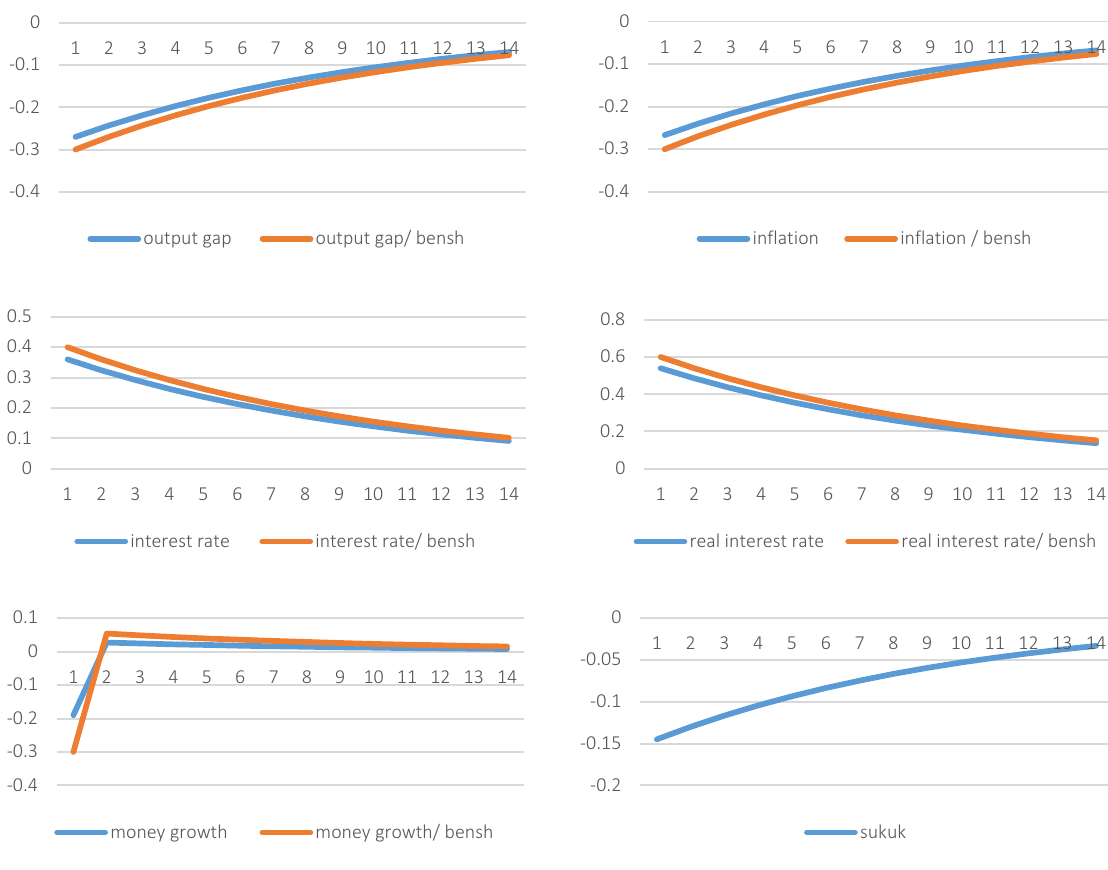
Figure 1. Effects of a monetary policy